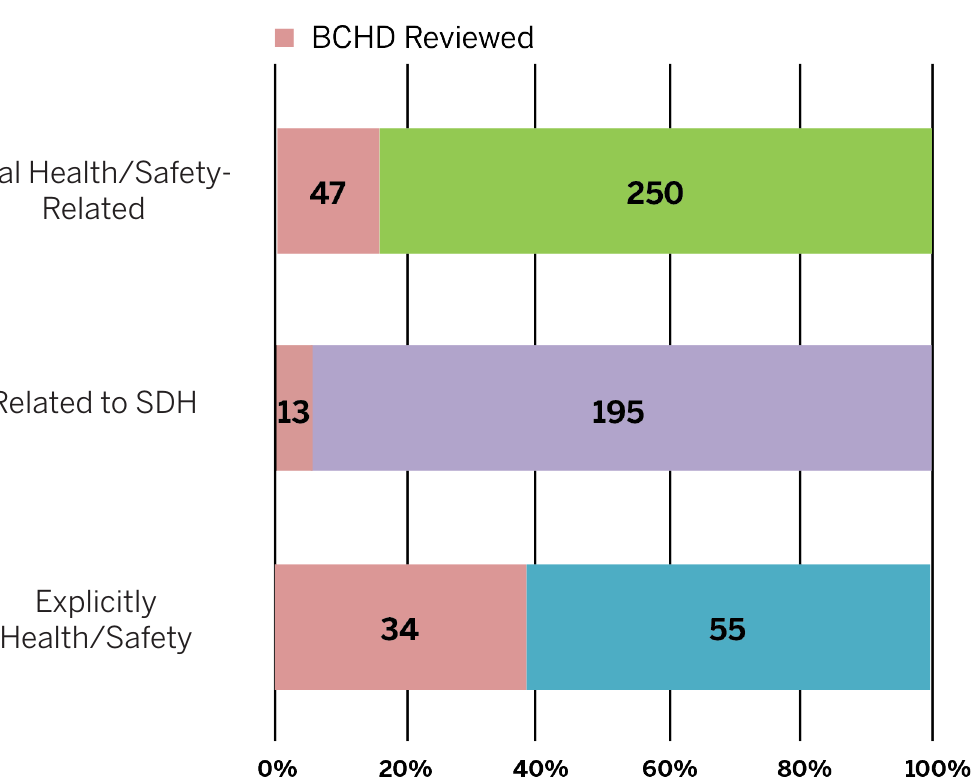
Figure 2: BCHD is Baltimore City Health Department. Note that a total of 17 policies were not on file in the database and were therefore not included in this